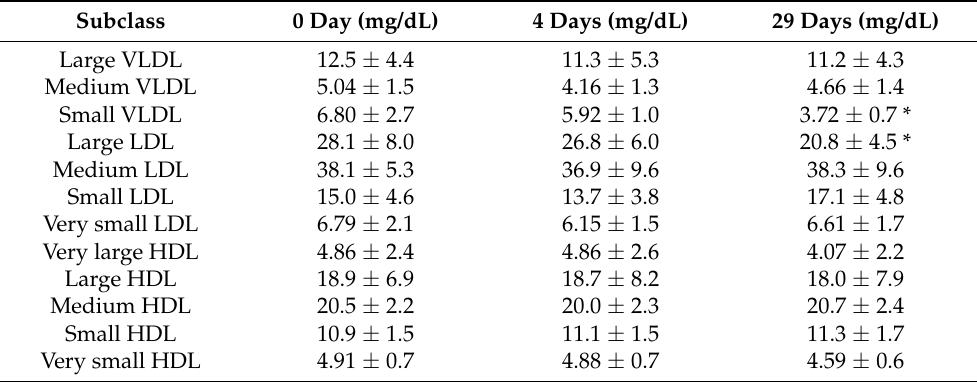
Table 2. Cholesterol concentration in lipoprotein